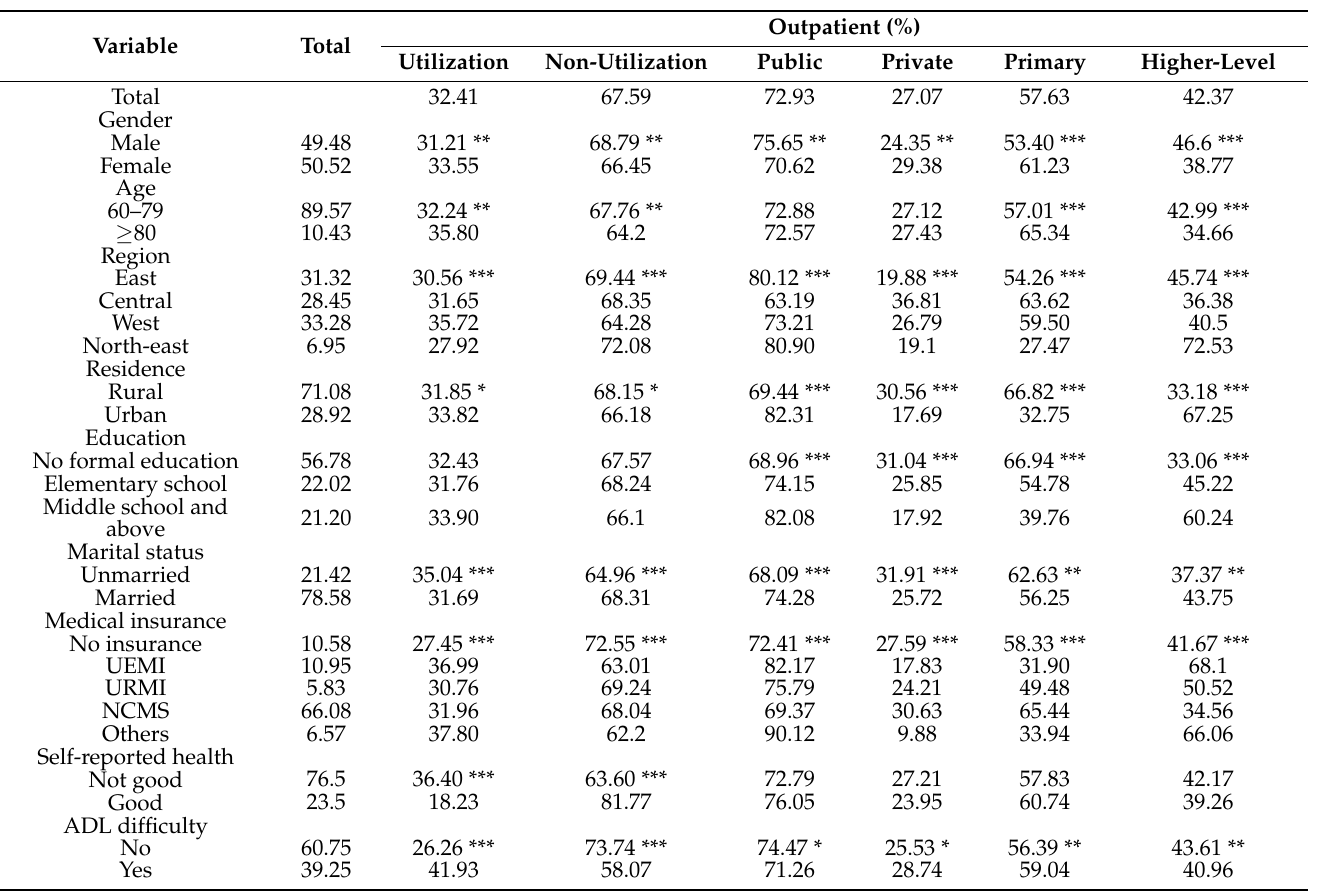
Table 1. Sample characteristics by outpatient healthcare utilization and the choices of outpatient healthcare providers ( N =